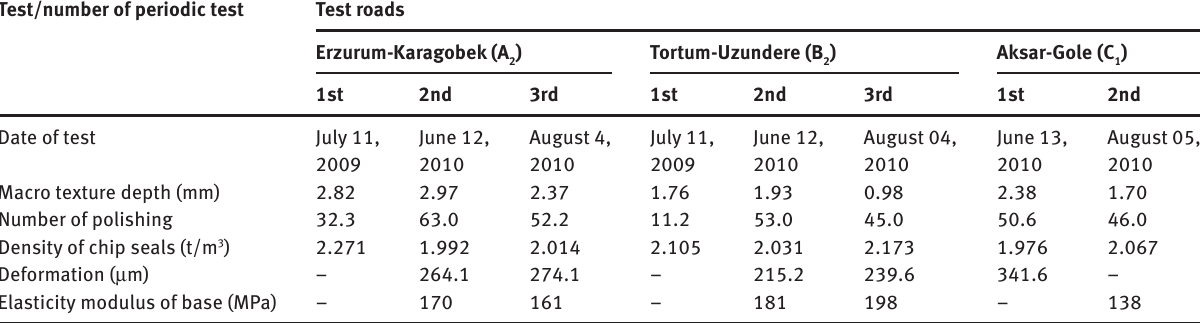
Table 7: Nondestructive test results of interval of the wheel path’s (2) points. Test/number of periodic test